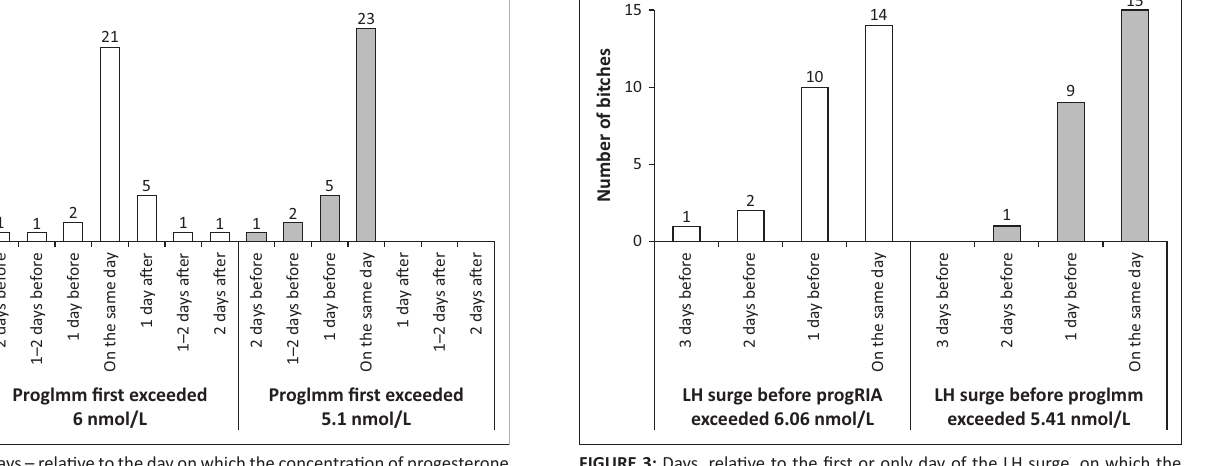
FIGURE 3: Days, relative to the first or only day of the LH surge, on which the concentration of progesterone measured with Coat-A-Count® radioimmunoassay in the plasma (progRIA) or with Immulite® 1000 LKPW1 in the serum (progImm) of bitches, respectively, first exceeded 6.06 nmol/L or 5.41 nmol/L (which were their mean concentrations on the day of the LH surge).